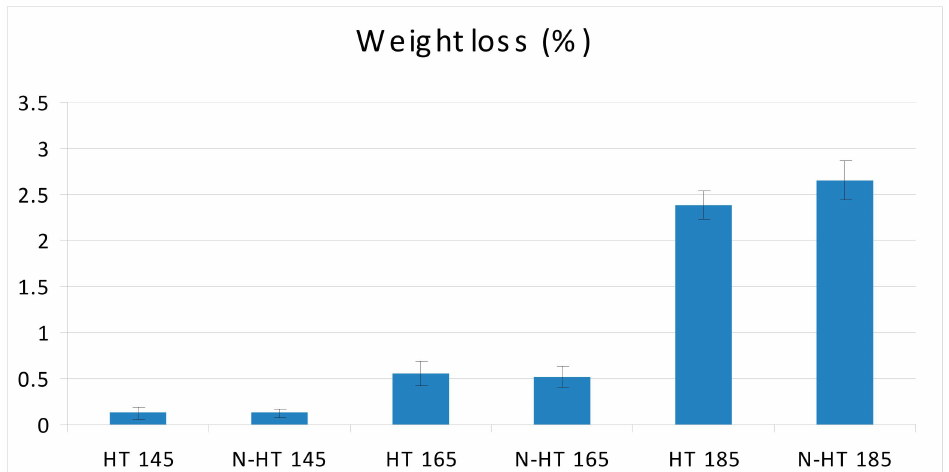
Figure 2. Weight losses in beech wood heat-treated at 145, 165, and 185 ◦ C and impregnated with silver